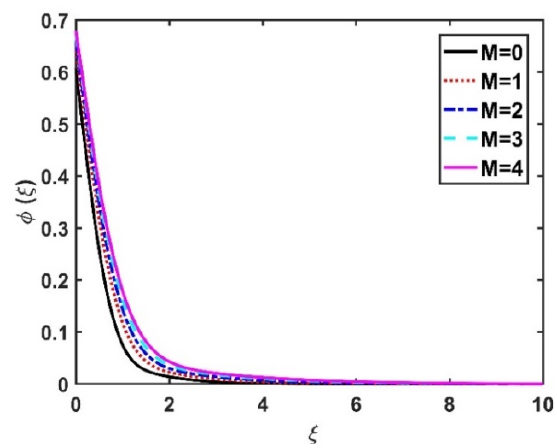
Figure 16. Impact of M on φ ( ξ )